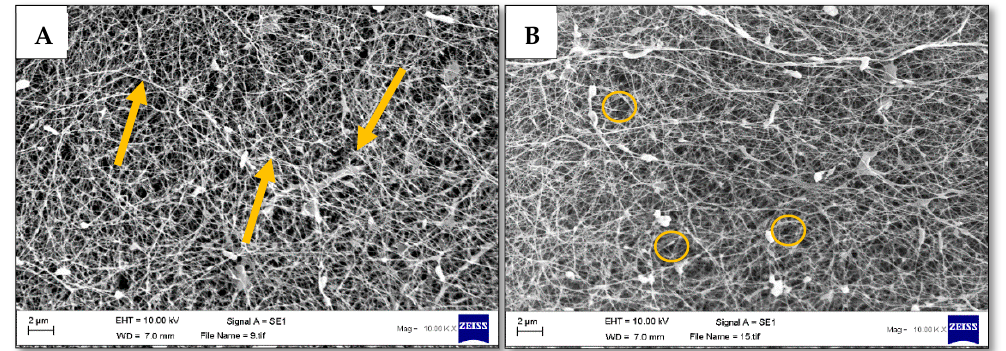
Figure 2. ( A,B ) Scanning electron micrographs of purified bacterial cellulose where the cellulose fibrils (arrows) and voids (circled) are clearly seen.